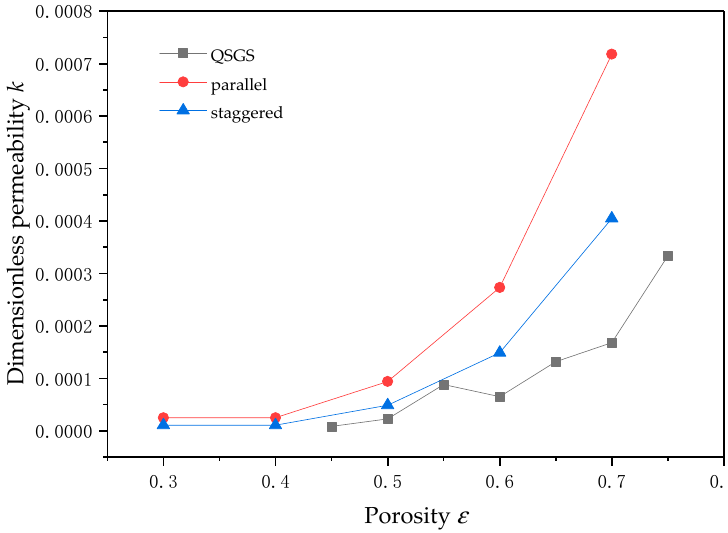
Figure 27. Relationships between porosity and dimensionless permeability of parallel, staggered and quartet structure generation set.